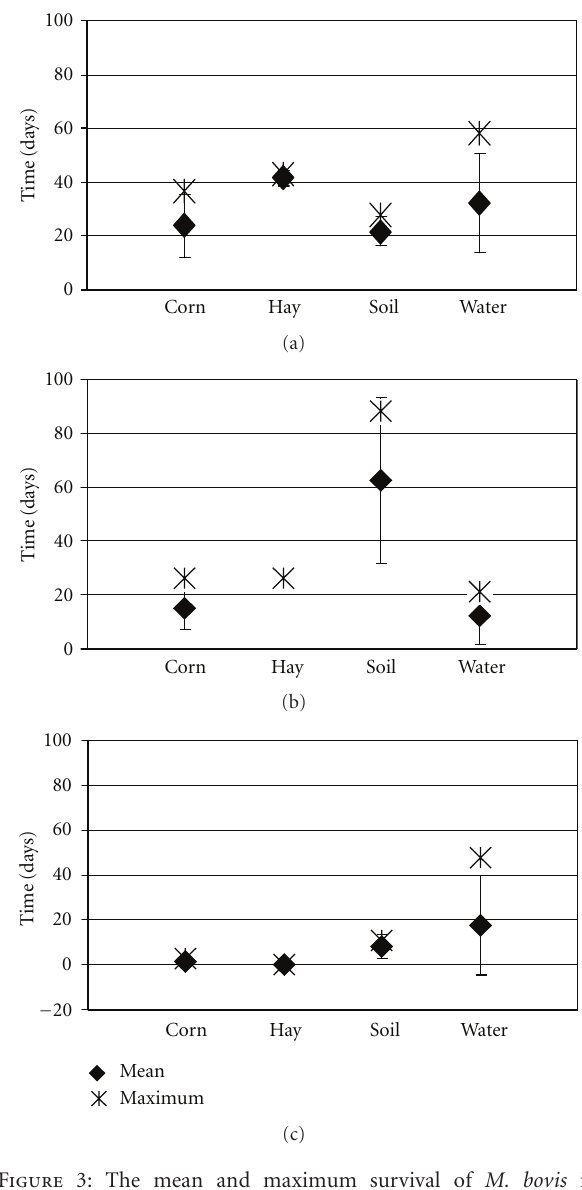
Figure 3: The mean and maximum survival of M. bovis in corn, hay, soil, and water exposed to environmental conditions in Fall/Winter (a), Winter/Spring (b), and Spring/Summer (c). Error bars represent standard